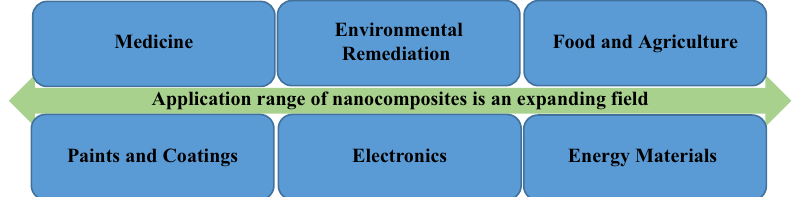
Figure 2: Various application ranges of nanocomposites that are continuously growing and